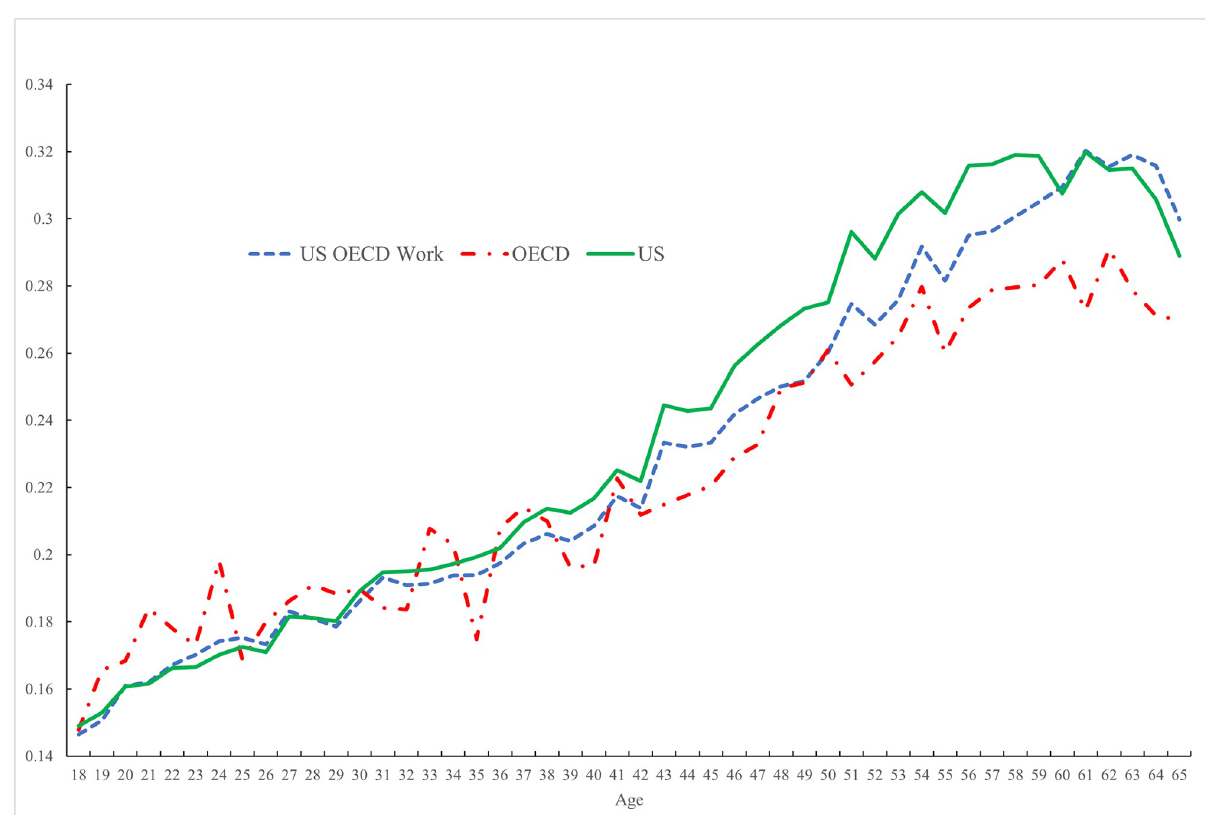
Fig 7. Simulation of age-pain profile in the United States having adjusted the age-employment (2009–2020).